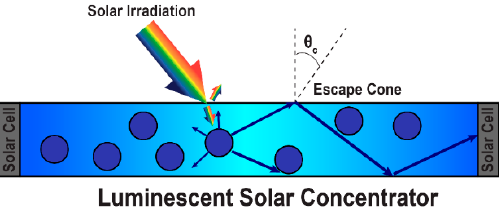
Figure 1. Schematic of a luminescent solar concentrator. Solar cells are usually placed at the device’s edges to collect the concentrated light emitted by the luminophores.